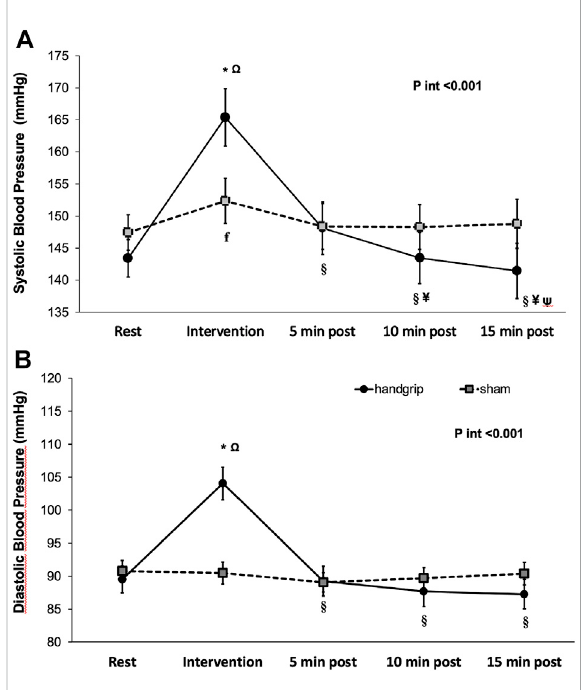
FIGURE 3 Systolic blood pressure (A) and Diastolic blood pressure (B) at laboratory during baseline, session and recovery period (mean ± SE). Legend: P int , p valuefor interaction * p < 0.03 between groups ; Ω p < 0.001 vs. baseline ꞙ p < 0.05 vs. baseline § p < 0.001 vs. session; # p < 0.05vs.session; ¥ p < 0.05vs.5 minrecoveryperiod; ψ p < 0.05 vs. 10 min recovery